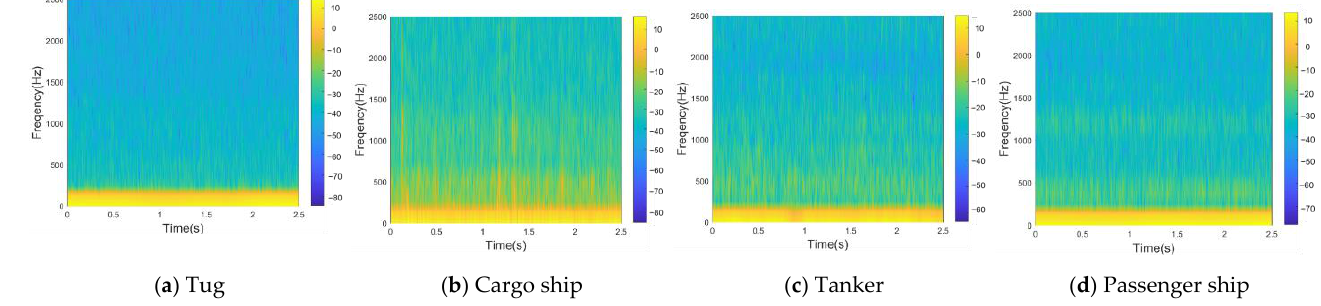
Figure 11. LOFAR spectrum of different types of ships.